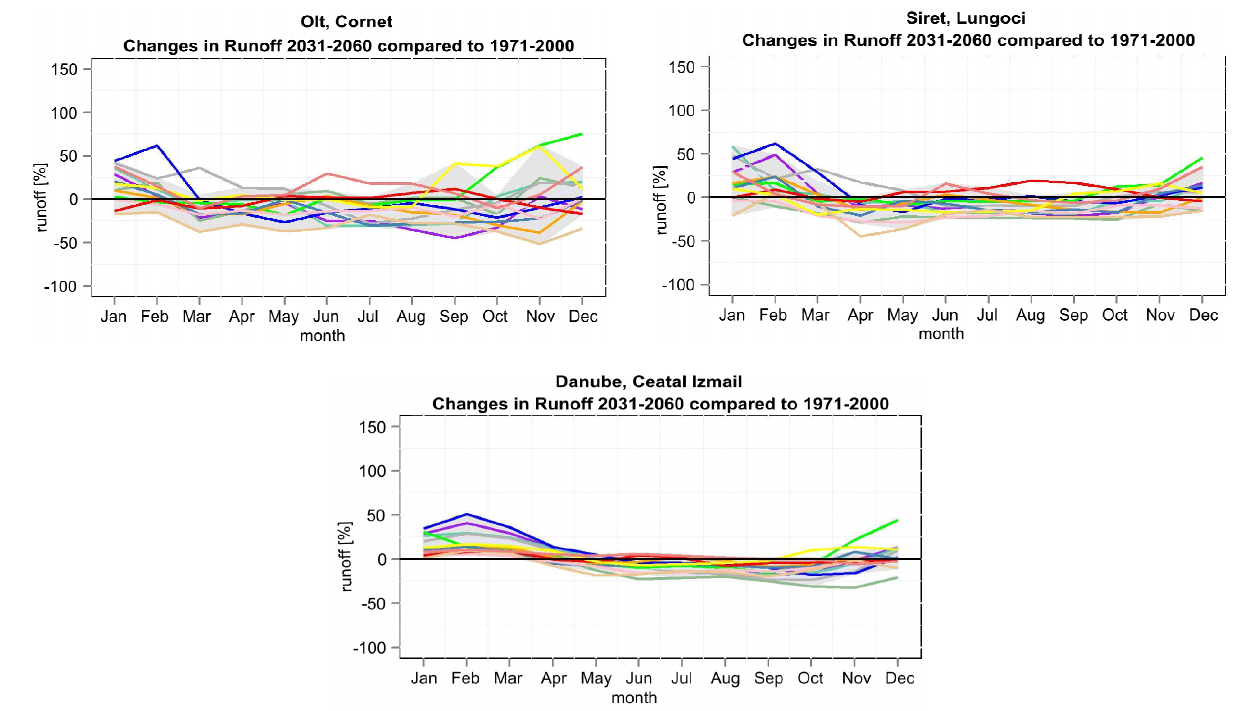
Figure 12. Changes (%) in the mean runoff seasonality between the reference period 1971–2000 and the near future scenario period 2031–2060 for selected stations in the Lower Danube River catchment. The grey ribbon comprises the range of results without